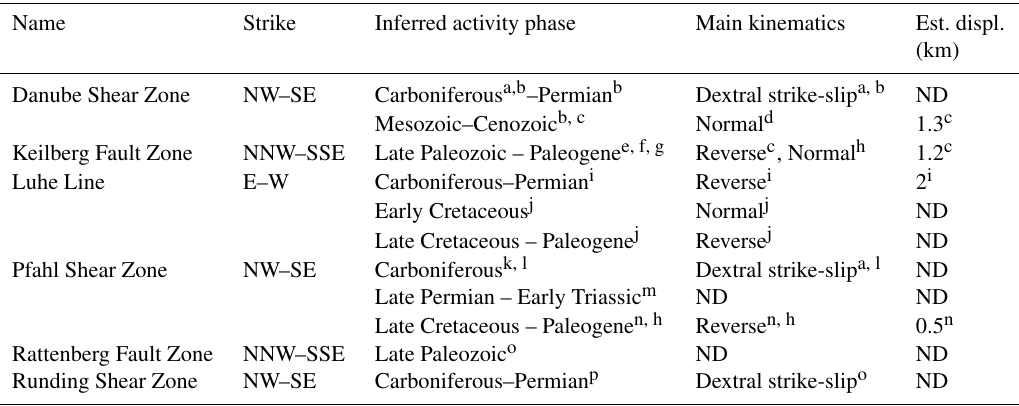
Table 2. Main inferred tectonic activity phases, kinematics, and estimated minimum displacements (est. displ.) of the six major fault zones in the Moldanubian Unit of the southwestern Bohemian